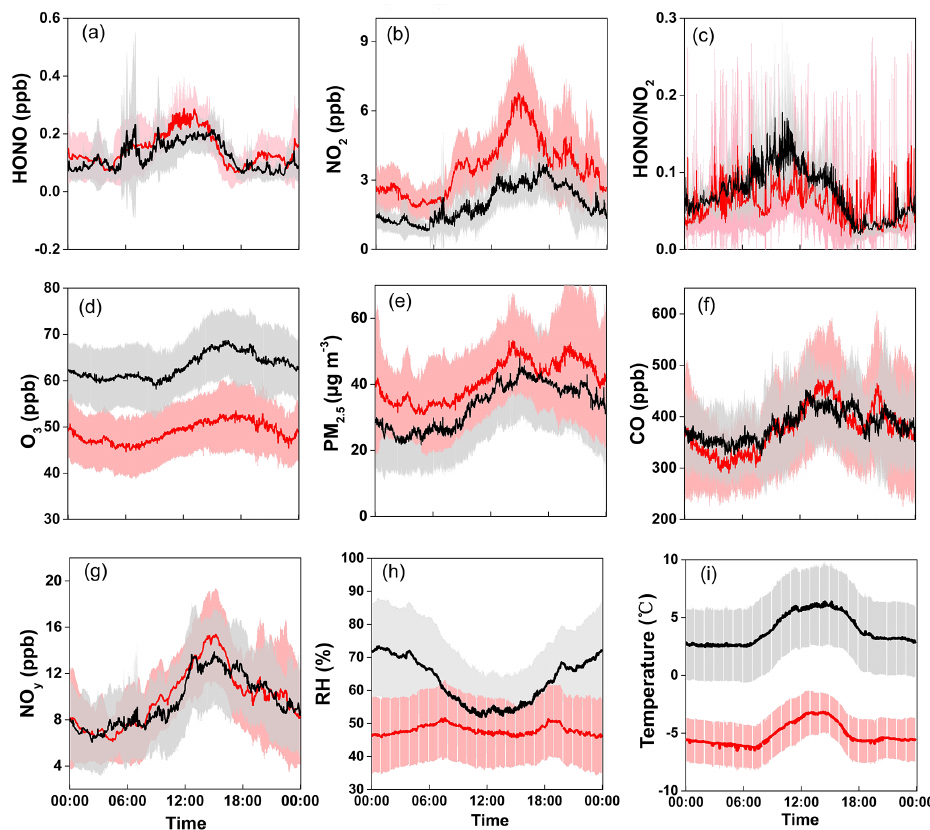
Figure 2. Average diurnal variations of (a) HONO, (b) NO 2 , (c) HONO / NO 2 , (d) O 3 , (e) PM 2 . 5 , (f) CO, (g) NO y , (h) RH, and (i) temper- ature in winter (red) and spring (black) at Mt. Tai. Shaded area indicates half of the standard deviation of the measurement data.